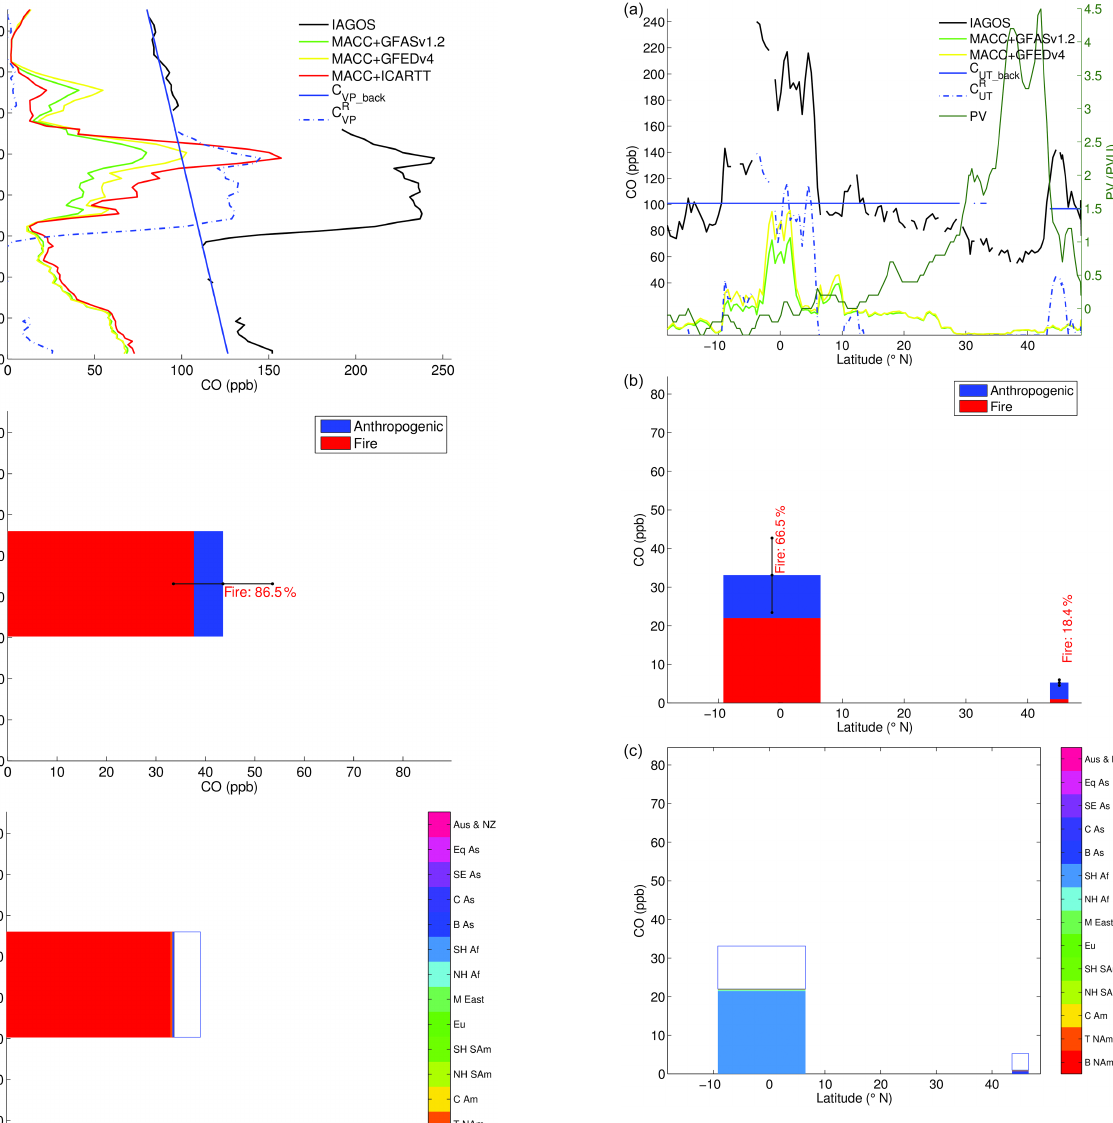
Figure 8. (a) Carbon monoxide as a function of latitude during the 30 July 2008 MOZAIC–IAGOS flight from Windhoek to Frank- furt. The black line indicates the observed CO, the blue line indi- cates the CO seasonal background deduced from the IAGOS data set and the dash-dotted line the residual CO mixing ratio. Light green and yellow lines indicate the simulated contributions us- ing MACCity for anthropogenic emissions and, respectively, GFAS v1.2 and GFED4 for biomass burning emissions. Dark green rep- resents potential vorticity (PVU) from ECMWF analyses. Simu- lated CO is separated into (b) source contribution (anthropogenic in blue, fires in red, standard deviation in black) and (c) regional biomass burning origins (14 regions defined for global emission inventory, http://www.globalfiredata.org/data.html, see Fig. S1; un- shaded blue square is for anthropogenic contribution), using MAC- City and GFAS